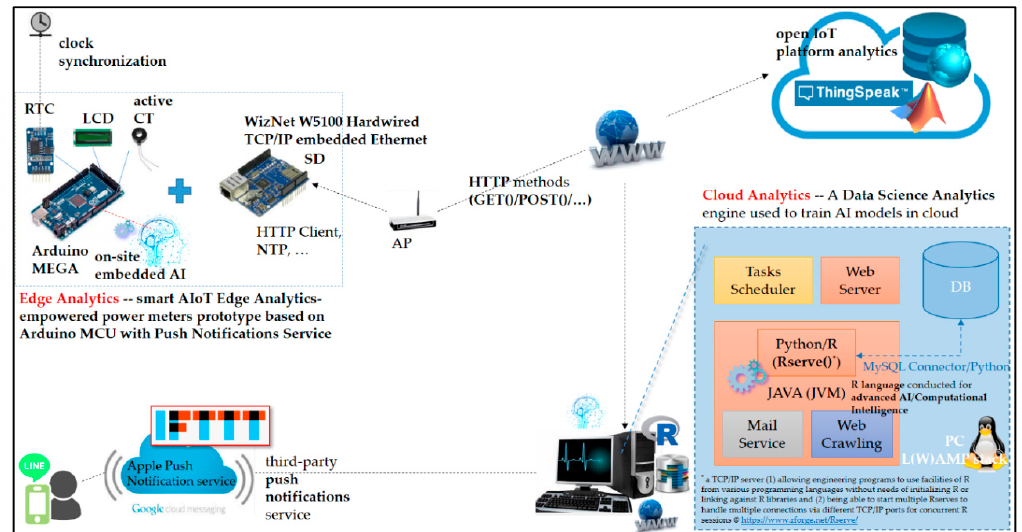
Figure 3. Described cloud analytics-assisted electrical EMS architecture empowered by the artificial intelligence (AI)-embedded and Arduino micro-controller unit (MCU)-based smart power meter prototype as edge analytics.